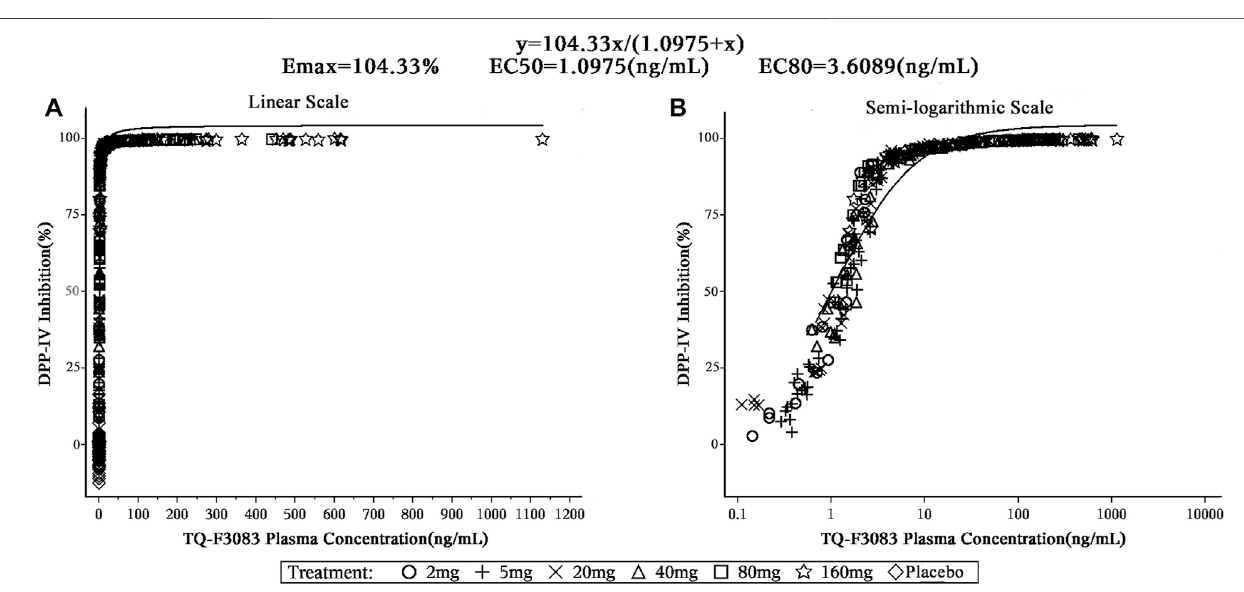
Frontiers in Pharmacology |